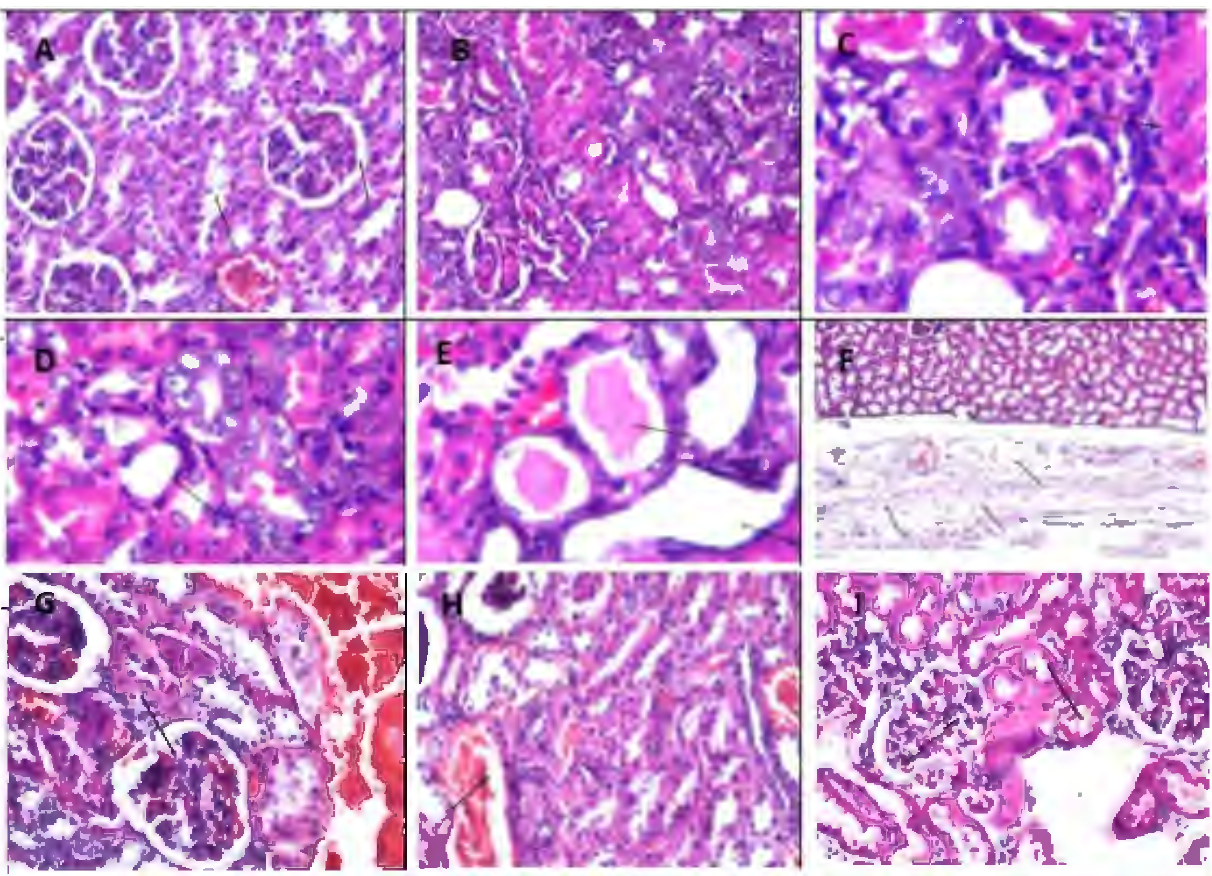
Figure 3. Photomicrographs of renal tissue specimens stained by H & E ( × 40). Photomicrograph ( A ): Transverse renal tissue section from the control group showed no histopathological alteration. The typical histological structure of the glomeruli and tubules at the cortex was recorded in ( A ). Photomicrographs ( B – E ): Transverse renal tissue section from AlCl 3 -treated animals showing focal inflammatory cell infiltration between the basophilic dysplastic renal tubules ( B – D ). Eosinophilic cast formation was detected in the lumen of some flattened lining epithelium tubules ( E ) (arrows). Photomicrographs ( F , G ): Transverse renal tissue section from the fluoxetine-treated animals showing inflammatory cell infiltration, and fibrosis with edema was observed in the capsule ( F ). There were focal hemorrhages between the tubules associated with congestion in the blood vessels at the cortex ( G ) (arrows). Photomicrograph ( H ): Transverse renal section from the wheatgrass group showing congestion in the cortical blood vessels ( H ) (arrows). Photomicrograph ( I ): Transverse renal tissue section from the combination group showing no histopathological alteration as recorded in ( I